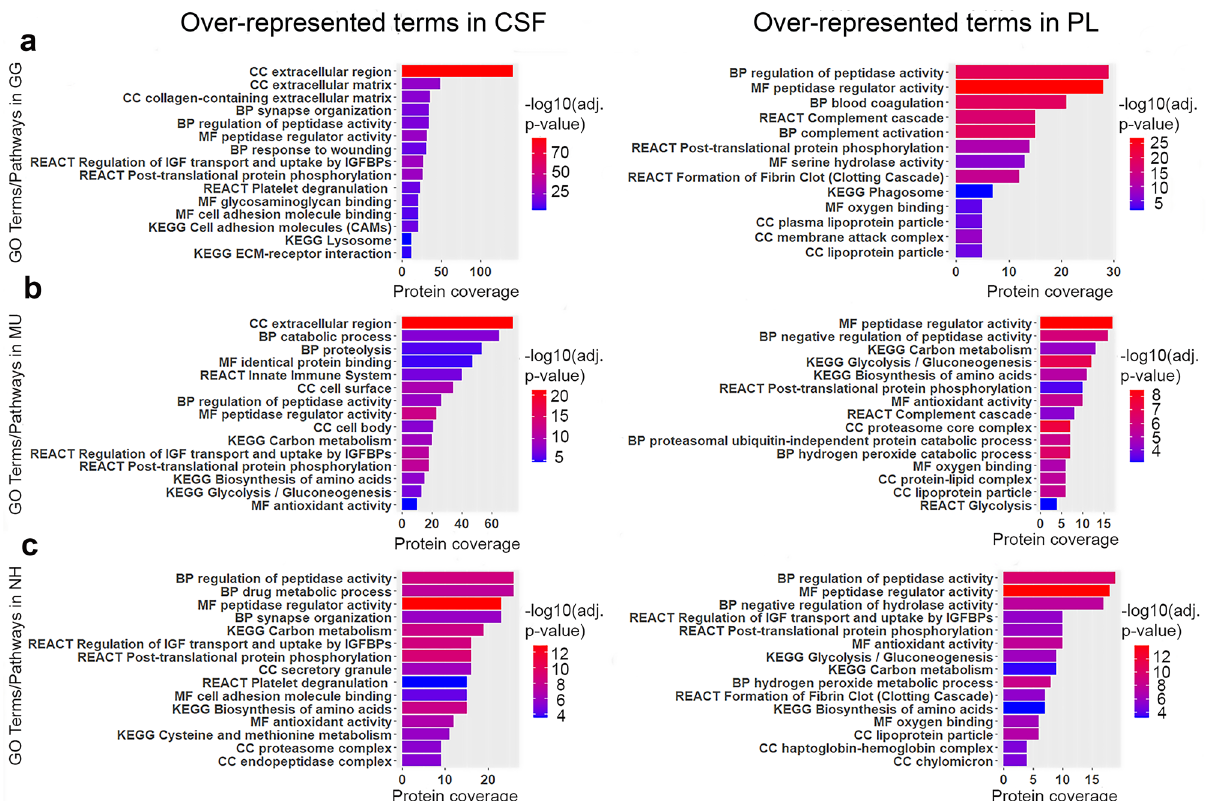
Figure 4. Top significant over-represented pathways revealed after functional enrichment analysis of the cerebrospinal fluid (CSF) and blood plasma (PL). Enriched pathways in CSF are shown on the left-hand side and in PL on the right-hand side for ( a ) chicken (GG), ( b ) budgerigar (MU) and ( c ) cockatiel (NH). The x-axis indicates the numbers of genes represented in each pathway, the y-axis indicates the GO (Molecular function, MF; Biological Process, BP; Cellular component, CC) or Pathways terms (KEGG, REACT) involved, and the colours represent the size of the negative log10 of the adjusted p value (adjusted p < 0.05). IGF Insulin-like Growth Factor; IGFBPs Insulin-like Growth Factor Binding Proteins (g:Profiler version e102_eg49_p15_ b486be1, https ://biit.cs.ut.ee/gprofi ler/gost; R version 4.0.0, www.r-proje